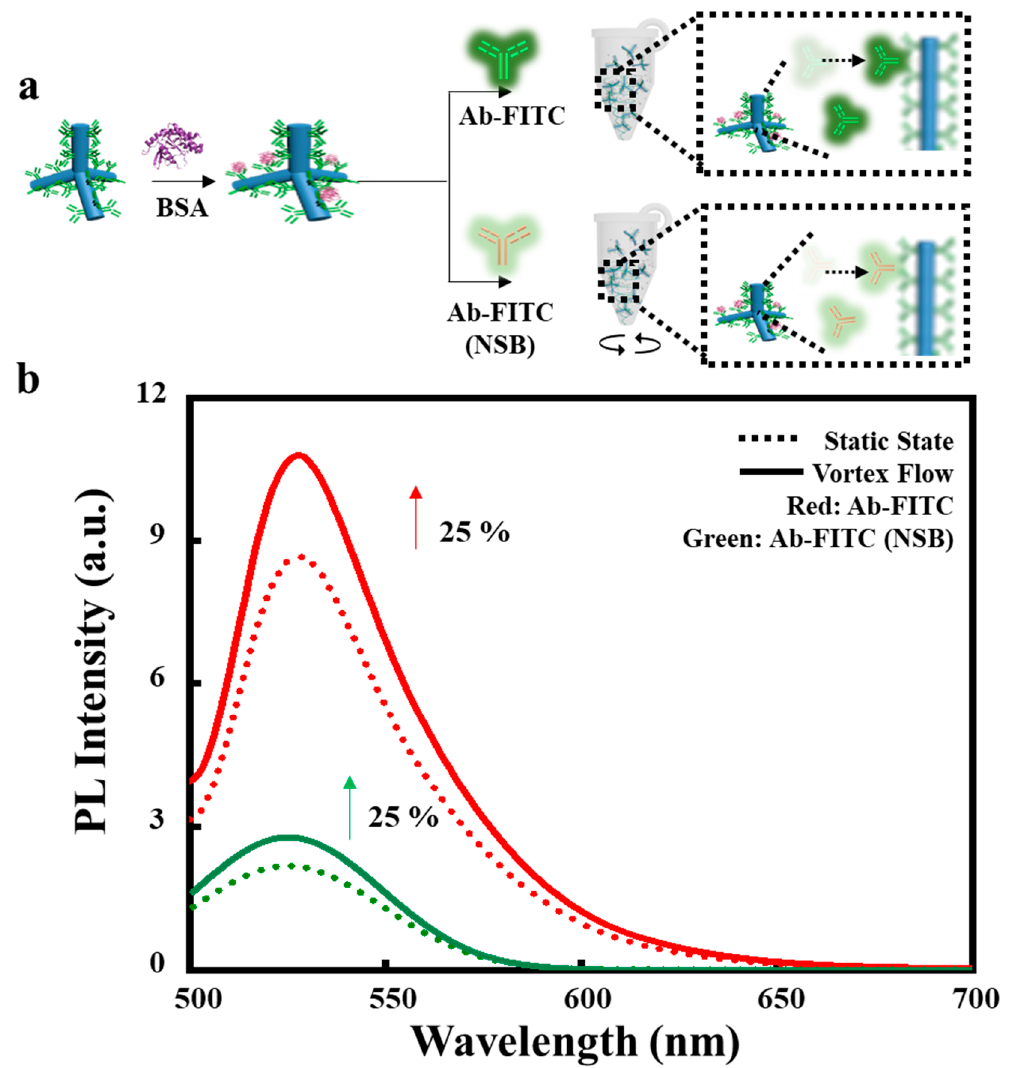
Figure 2. Protein capture before and after rotation. ( a ), Schematic of the CdSe TP functionalized with the primary antibody and BSA as a blocking agent. The PL intensities were compared to evaluate complexes before and after vortex flow. ( b ), PL spectra of the complexes with anti-goat IgG antibody and anti-mouse IgG antibody before and after vortex flow. Rotation time, 30 min. Rotation rate, 1000 rpm.